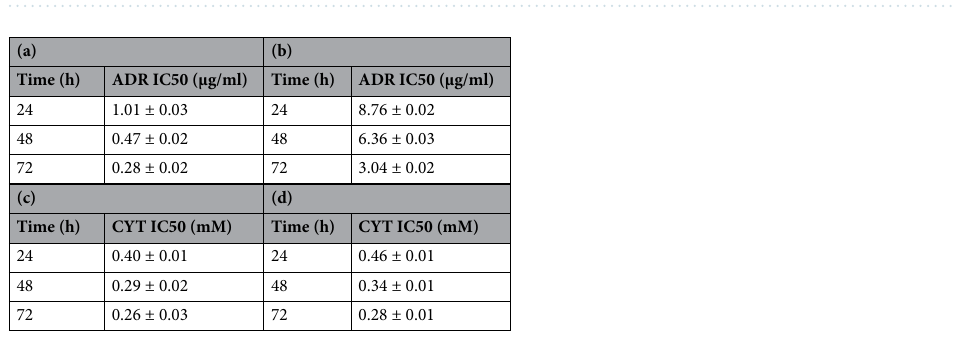
Figure 1. Effects of CYT and ADR on cytotoxicity and proliferation of MCF-7 and MCF-7/ADR cells. ( a,b ) CCK-8 assay showed that ADR inhibited the proliferation of MCF-7 and MCF-7/ADR cells (n = 6). ( c,d ) CCK-8 assay showed that CYT inhibited the proliferation of MCF-7 and MCF-7/ADR cells (n = 6). ( e,f ) ADR combined with CYT inhibited the proliferation of MCF-7 and MCF-7/ADR cells, as compared with the monotherapy group. The values are obtained from three independent experiments and shown as mean ± S.D. ** p < .01. ( g,h ) The clone formation rates of the ADR, CYT, and ADR + CYT groups were lower than that of the control group, and the ADR + CYT group had the lowest rate in MCF-7 and MCF-7/ADR cells. The values are obtained from three independent experiments and shown as mean ± S.D. ** p < .01.